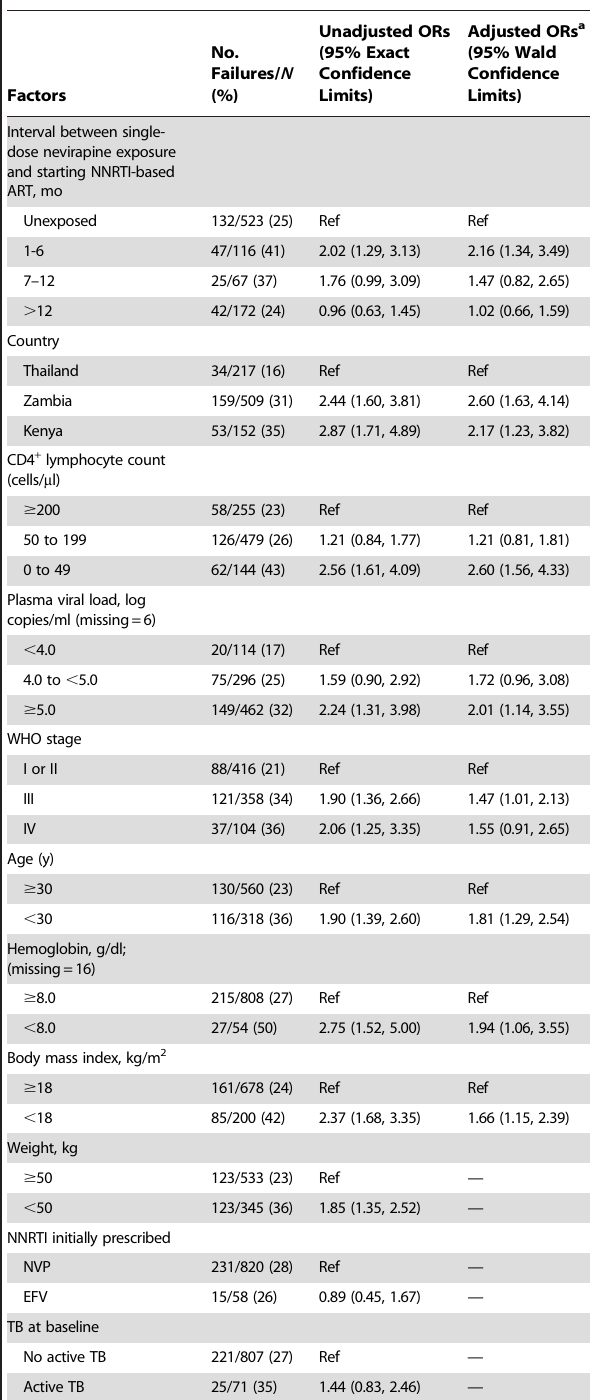
Unadjusted ORs (95% Exact Confidence Limits)